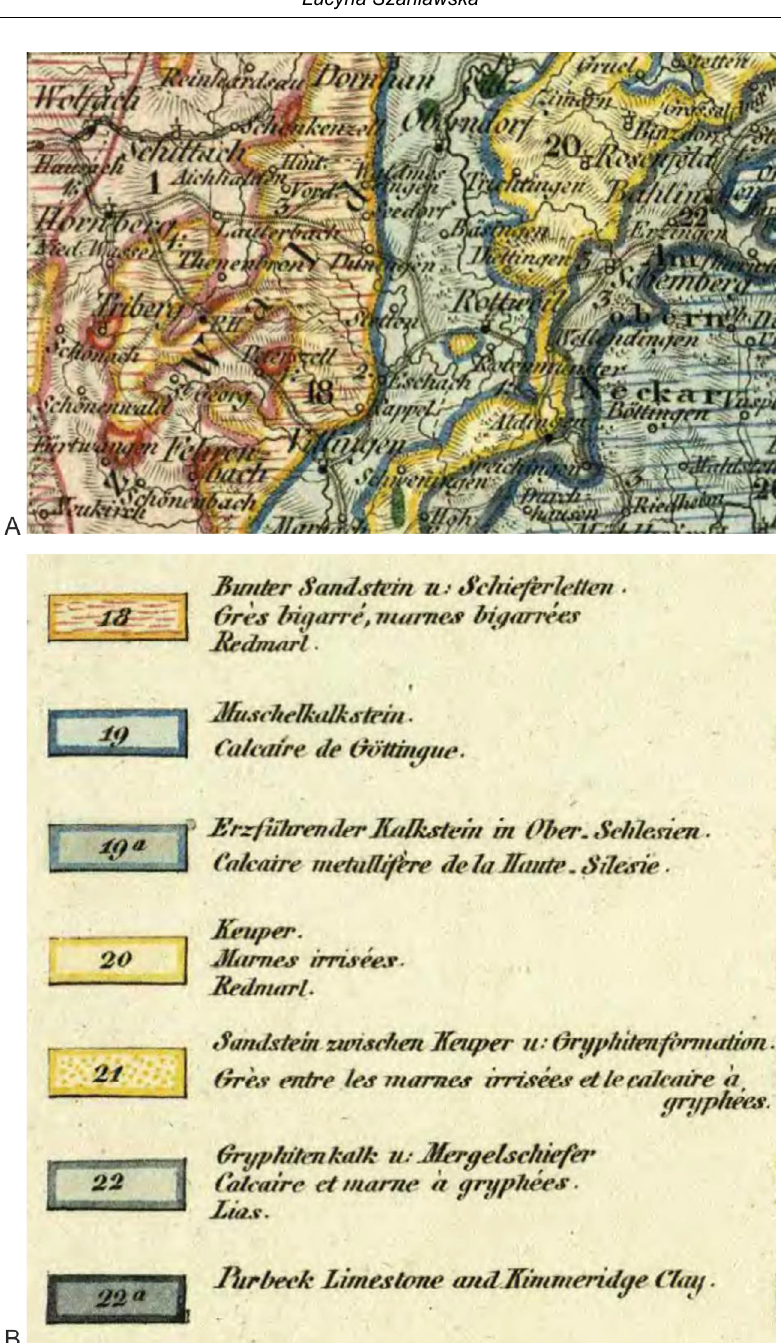
Fig. 8. Part of the sheet München from the map of Leopold von Buch, Geognostische Karte von Deutschland … − A and its explanation − B (from the collection of the Central Library of Geography and Environmental Protection, Polish Academy of